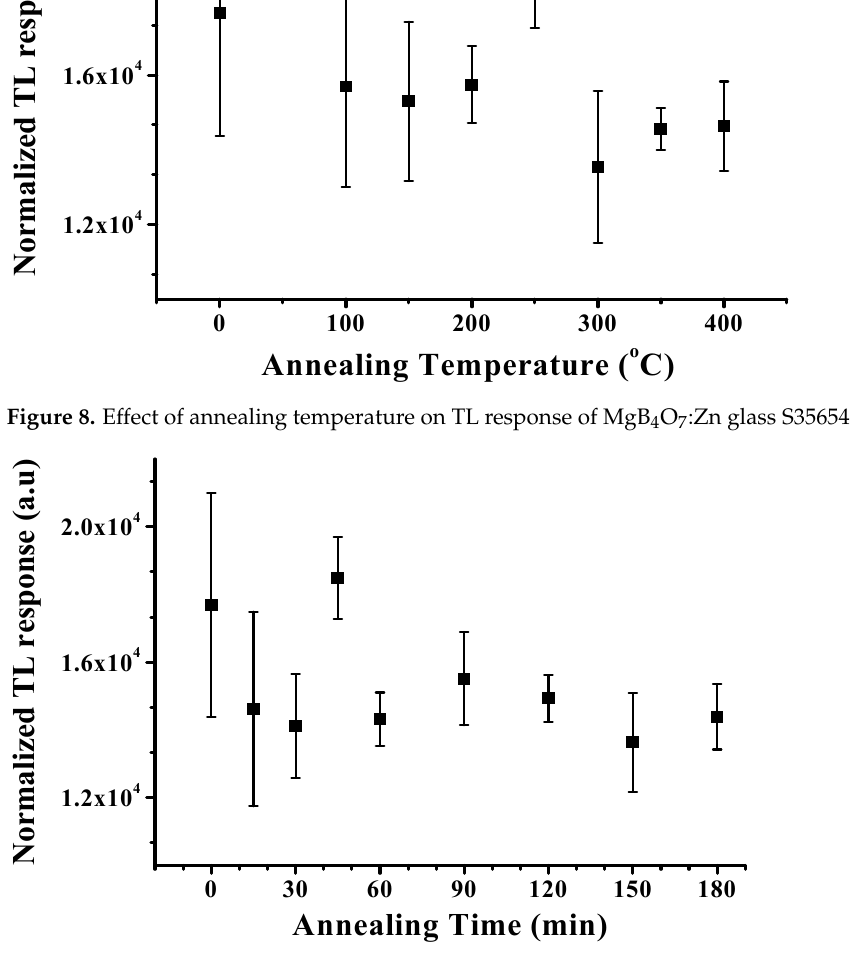
Figure 9. Effect of annealing time on TL response of MgB 4 O 7 :Zn glass S35654.